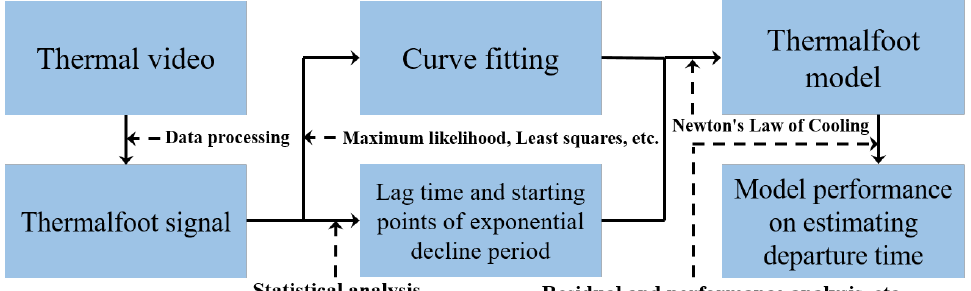
Figure 2. Workflow of the proposed